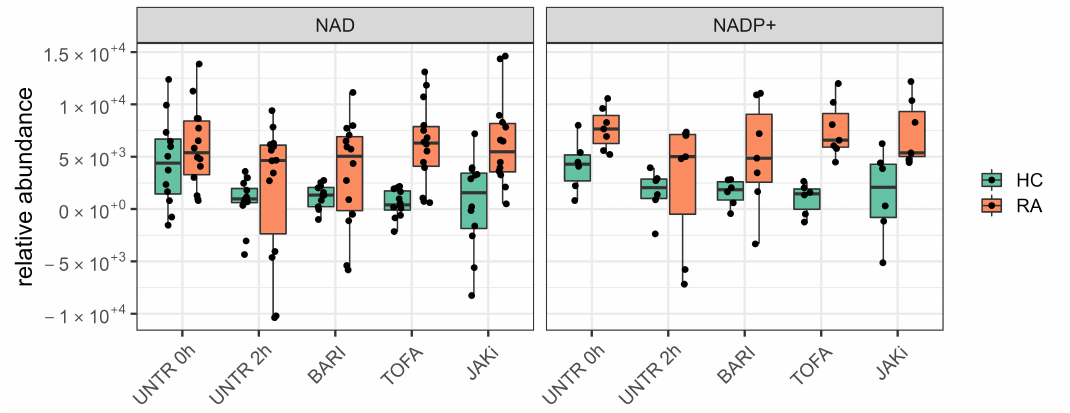
Figure 4. Boxplots comparing abundance of NAD and NADP+ in HC and RA neutrophils across all conditions tested. (UNTR = Untreated, BARI = Baricitinib, TOFA = Tofacitinib, JAKi = Pan- Jak